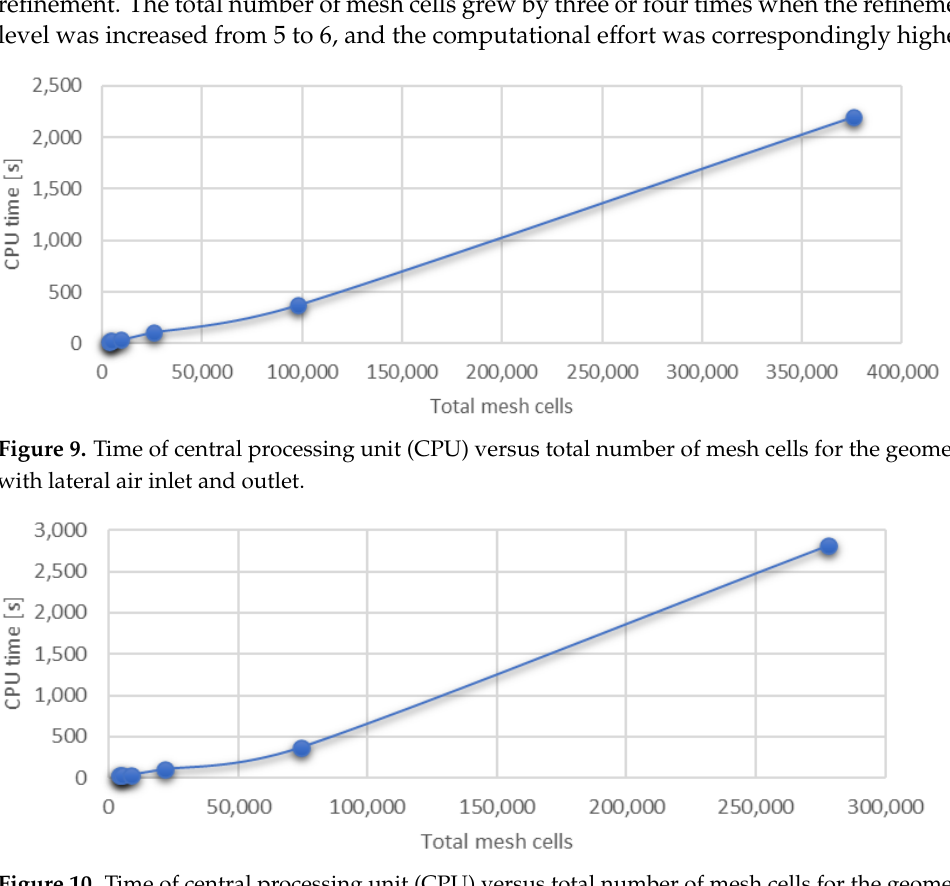
Figure 8. Maximum velocity of each refinement versus total number of mesh cells for the geometry with upper air inlet and outlet.